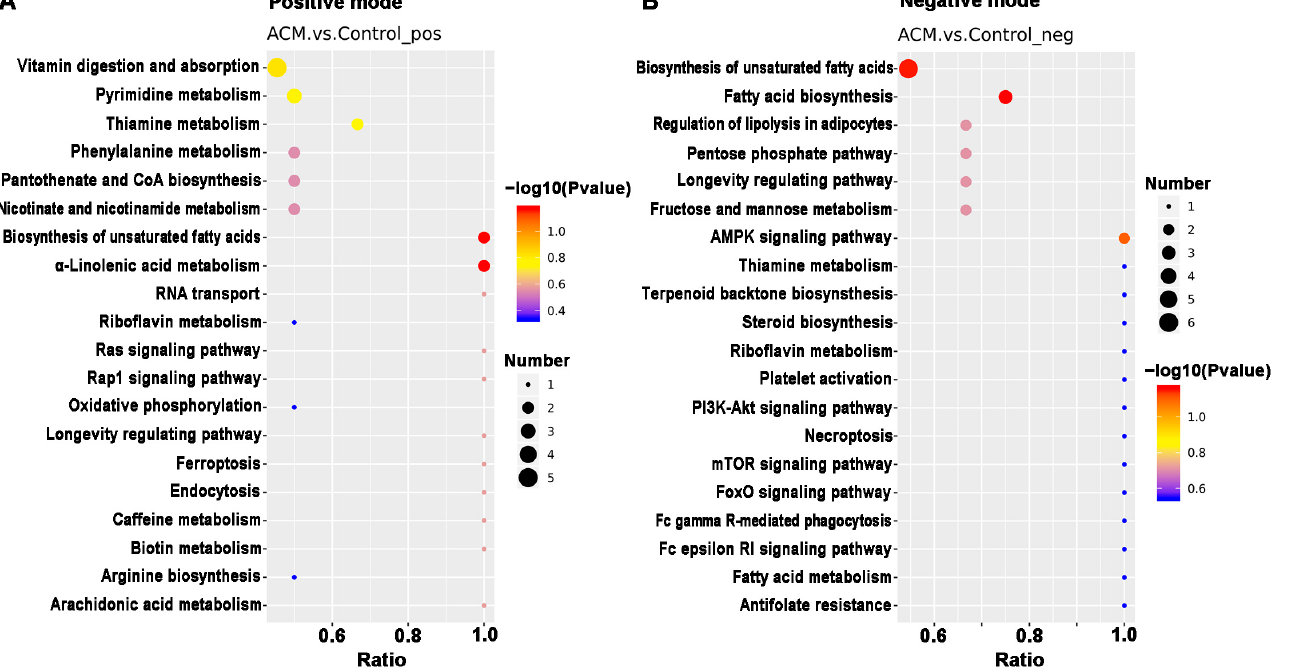
Figure 7. The top 20 KEGG pathways related to differentially expressed metabolites between the control and ACM groups. ( A ) Positive mode; ( B ) negative mode. Table 2. The main KEGG pathways based on the differentially expressed metabolites.